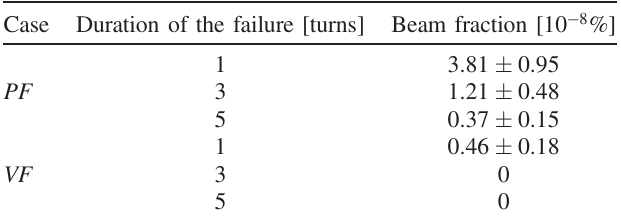
TABLE V. Percentage of beam that impacts on the aperture integrated over the ten remaining turns after the failures for the PF and VF cases using SG II. For SG III distribution only the PF in